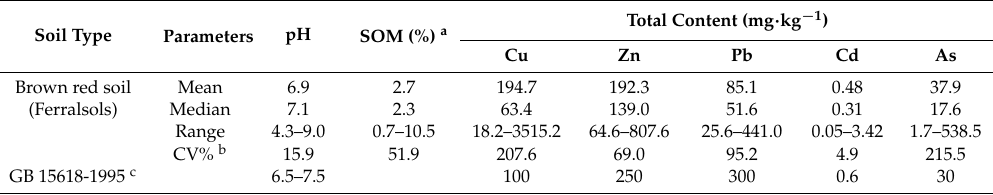
Table 1. Characteristics of soils collected in the study area.